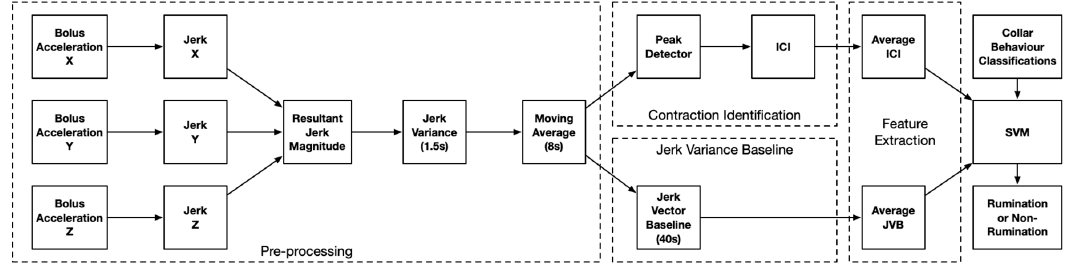
Figure 3. The overview of the processing of the bolus accelerometer data.